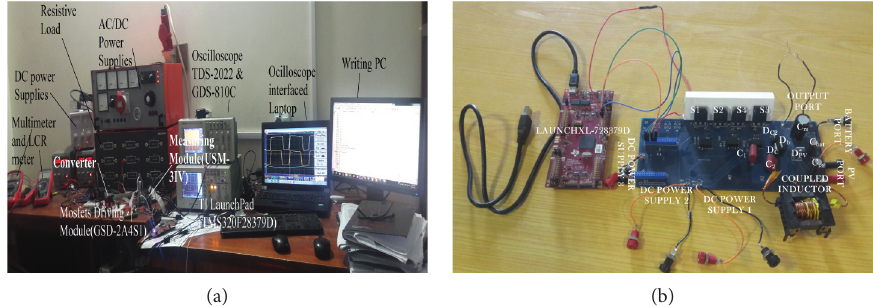
Figure 10: (a) Workstation photograph. (b) Hardware prototype.